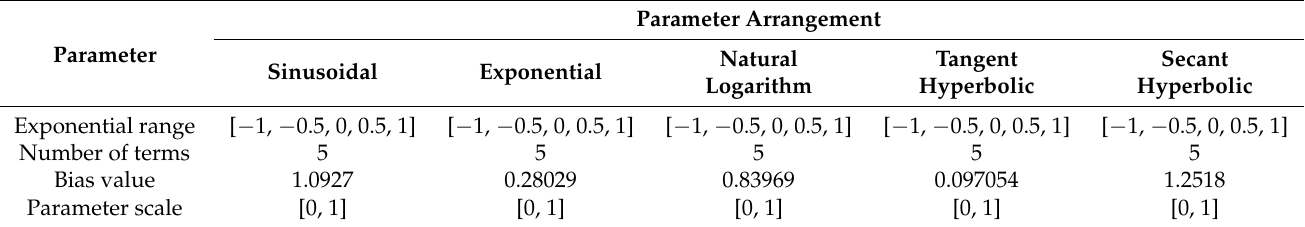
Table 4. Details of arranged parameters of EPR models for prediction of coefficient of stress